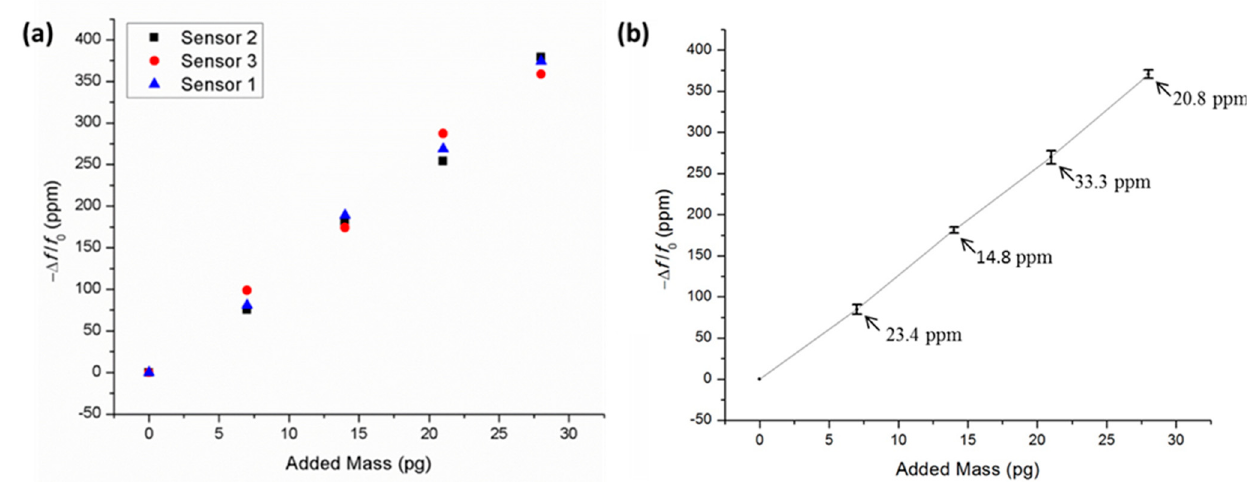
Figure 10. ( a ) Measured fractional frequency shifts versus added mass; and ( b ) y-error of the mass-loading induced fractional frequency shift for three 40 μ m-radius disk resonator based mass sensors operating at the fourth-order contour